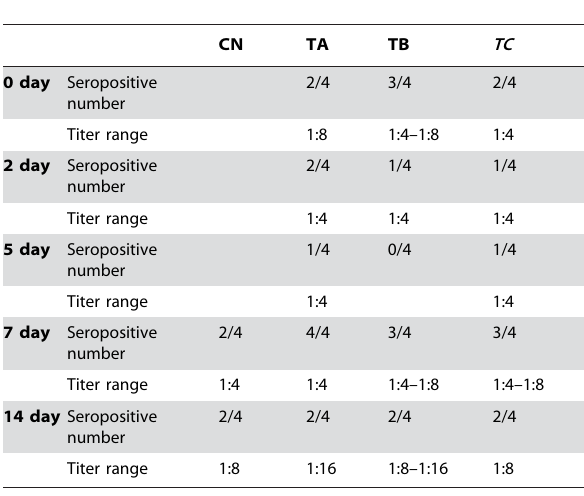
Table 3. Summary of neutralizing antibody titers of monkey following viral challenge after immunization.